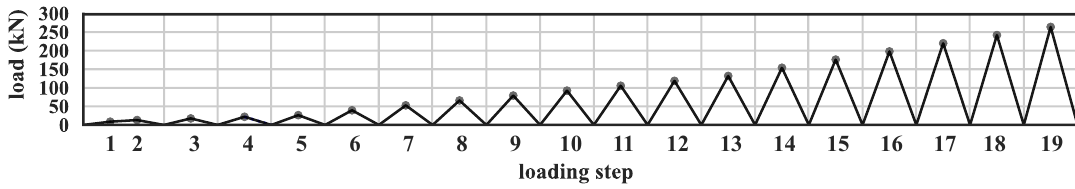
Figure 7. Loading-unloading sequence for the load test.